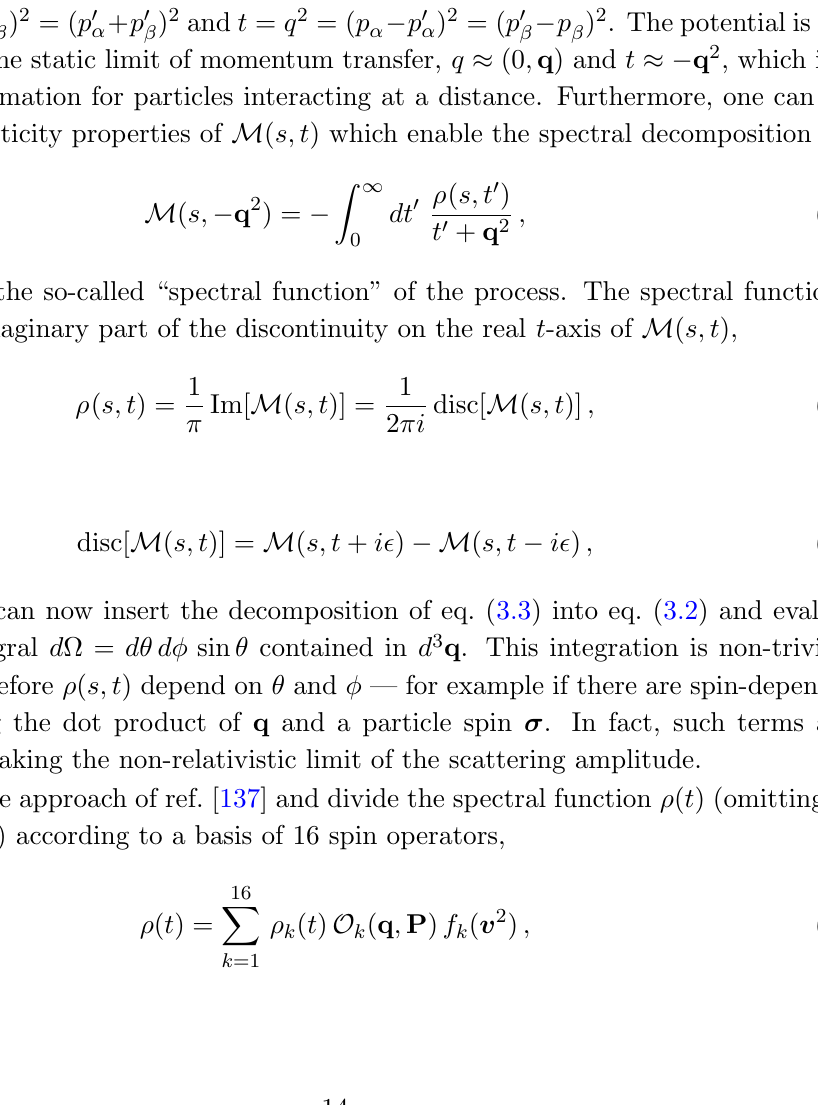
(cid:0) p 0 = p 0 (cid:0) p . Right: diagram depicting the exchange of two (cid:11) (cid:11) (cid:12) (cid:12) and c XY respectively, where the superscripts X; Y = L; R refer (cid:11)(cid:11) ; ij (cid:12)(cid:12) ; ij